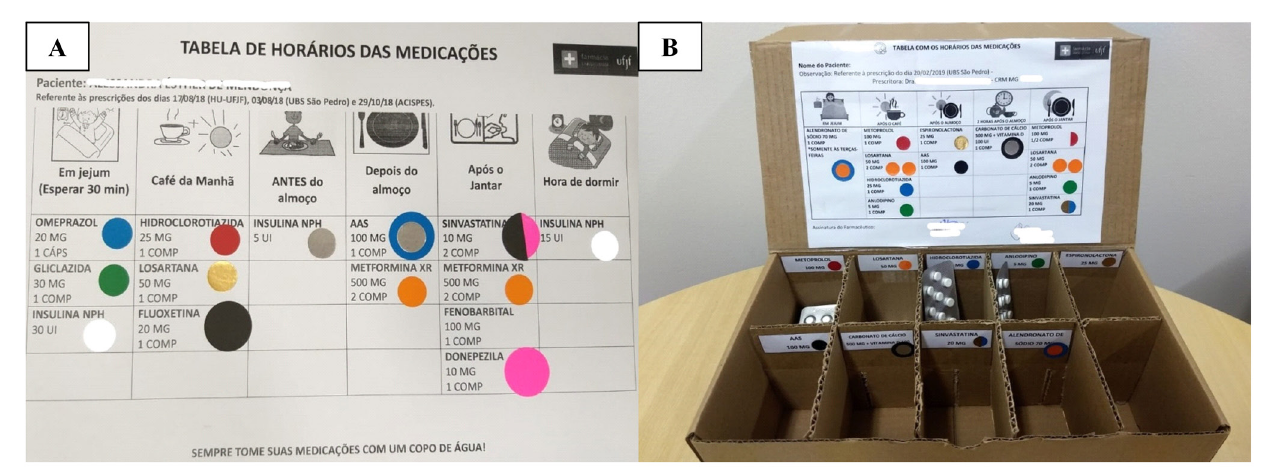
FIGURE 4 - Examples of educational materials provided to patients by the Pharmaceutical Care Program. Legend: Daily Medication Schedule (A); Medicine Organizer Box